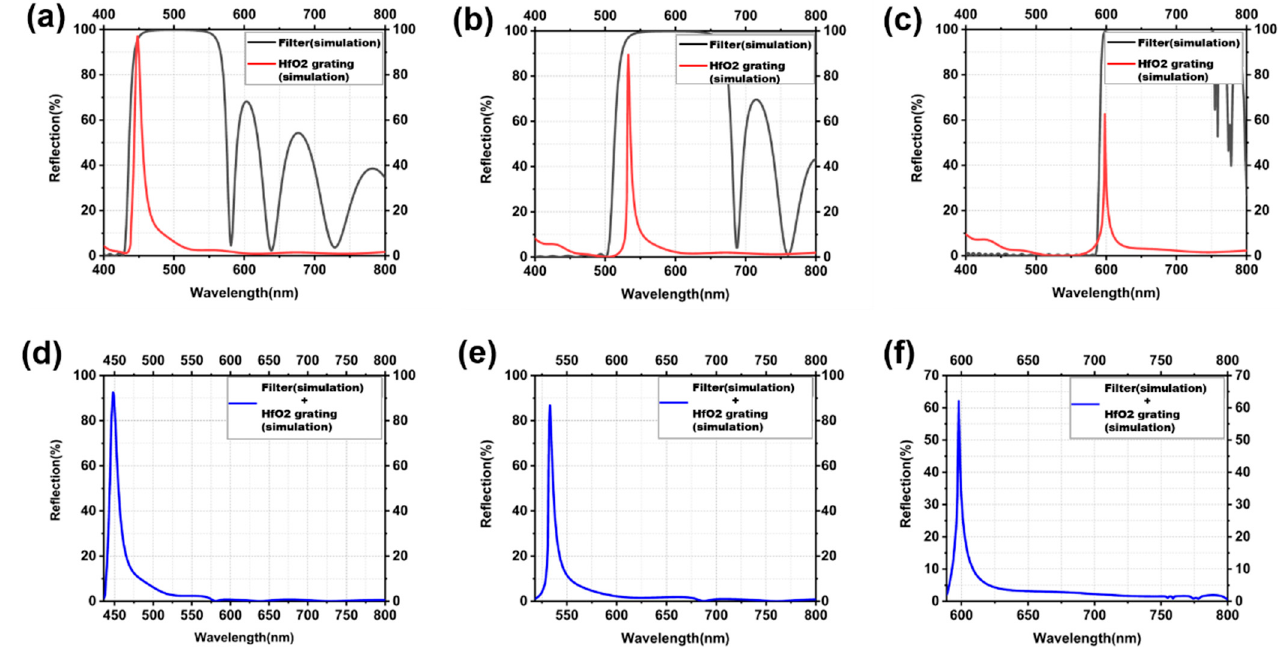
Figure 3. The light was incident at 15°, ( a – c ) correspond to the blue, green, red, black lines in the optical three primary colors represent the reflection spectrum of the filter, and the red line represents the reflection spectrum of the HfO 2 grating. ( d – f ) Reflectance spectra of filters and HfO 2 gratings.